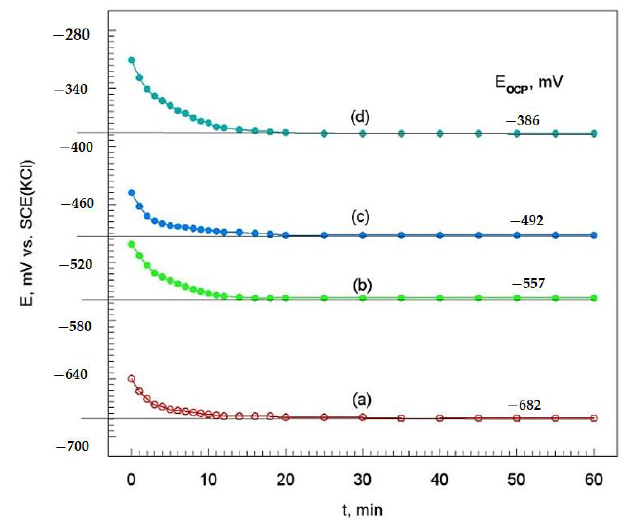
Figure 9. Open-circuit potential of the Cr 3 C 2 -25(Ni20Cr) cermet coatings on the Al7075 substrate: ( a ) before, and after laser remelting for the spot speed: ( b ) 1000 mm/min, ( c ) 800 mm/min, and ( d ) 600 mm/min. Solution contained 1.2 M Cl − , pH 1.5.